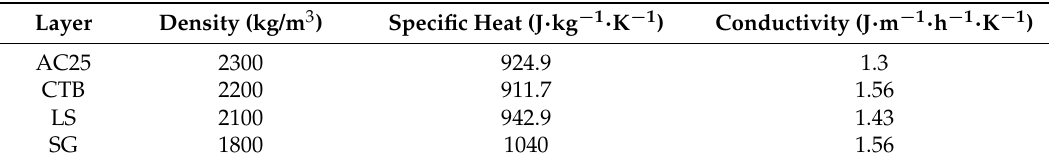
Table 12. Thermally physical properties of each layer.